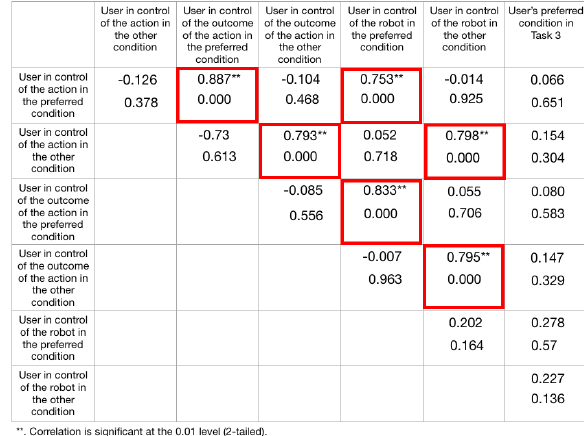
Figure 15: Correlation table for Task 3 "Dance" between the par- ticipant’s preferred condition and the participant’s perception of control for their preferred condition and their non-preferred condi-